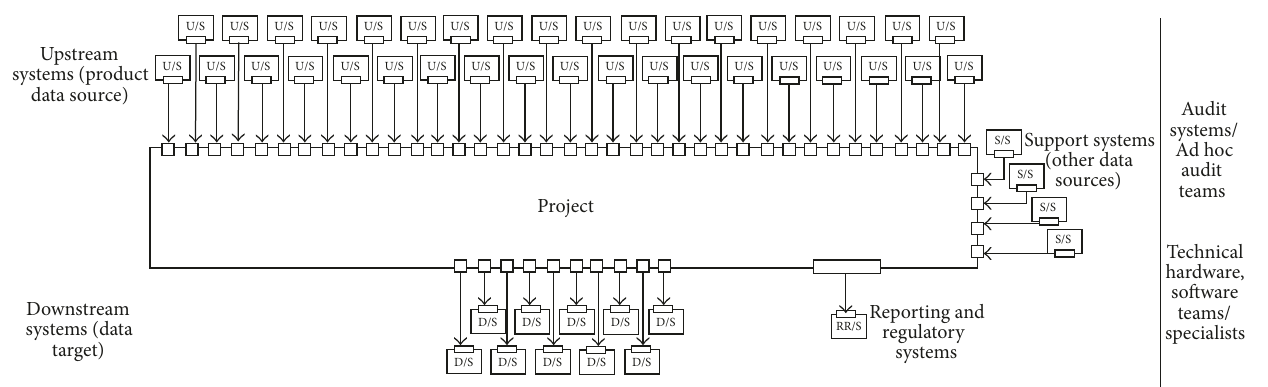
Figure 7: Project organization chart.